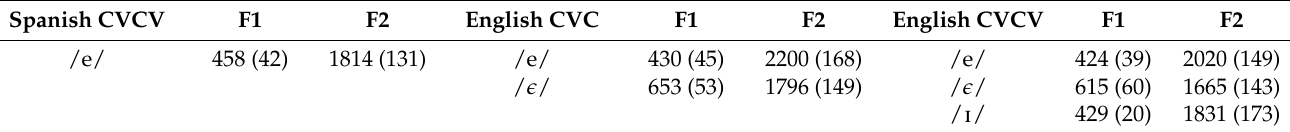
Table 3. F1 and F2 values of Spanish and American English vowels, Bradlow (1995). Spanish